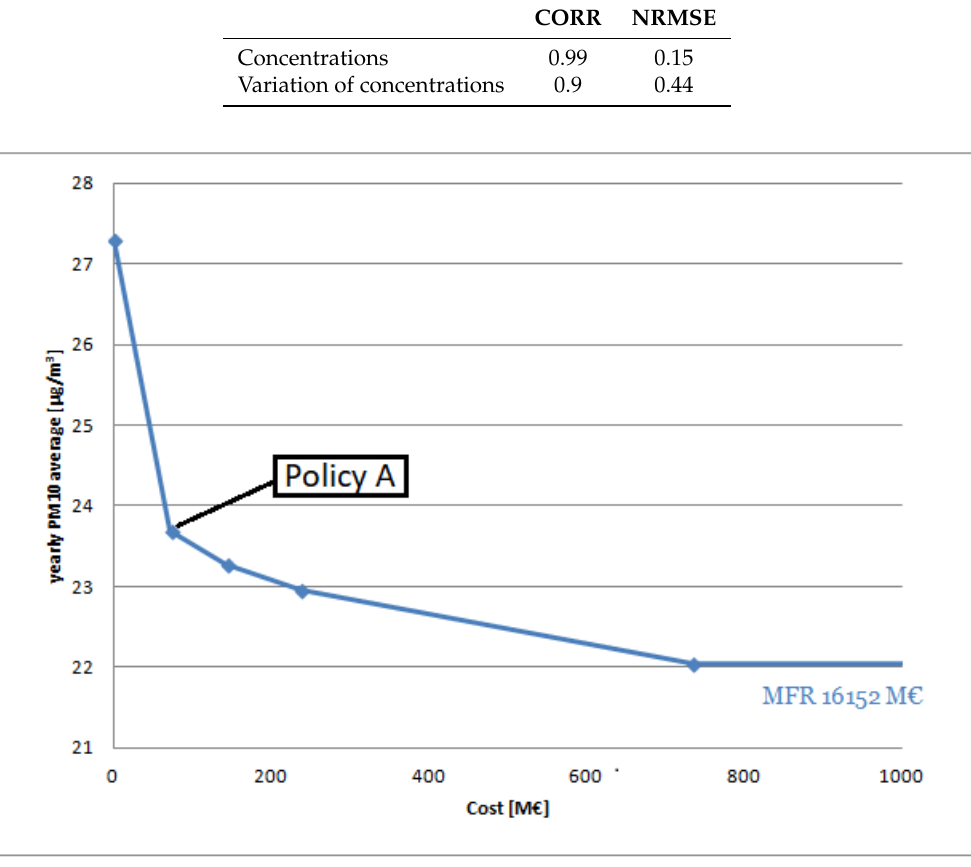
Figure 3. Pareto curve presenting the solutions of the Step 1